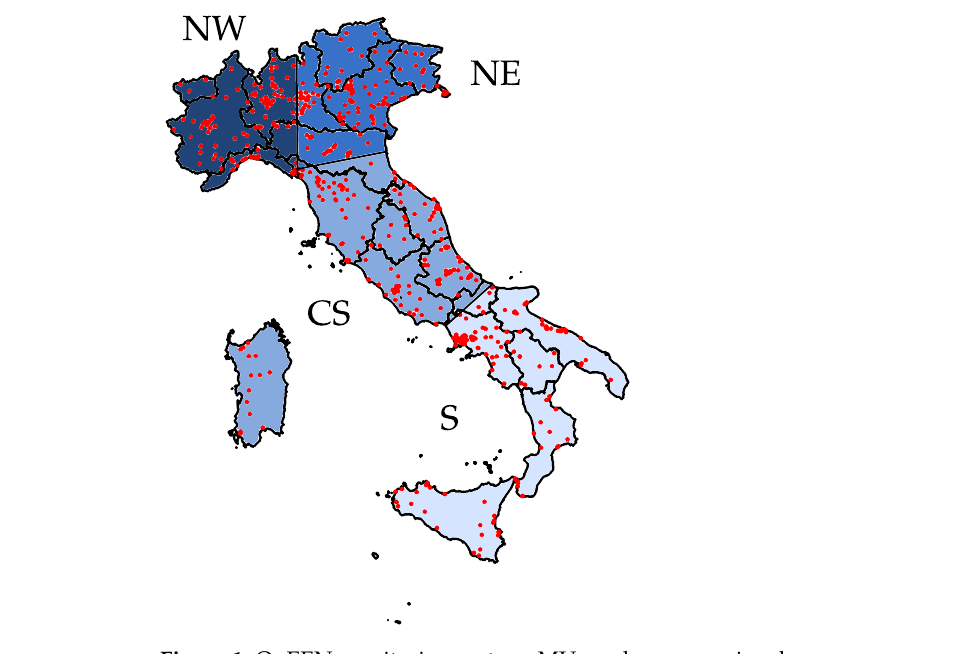
Figure 1. QuEEN monitoring system: MUs and macro-regional areas.